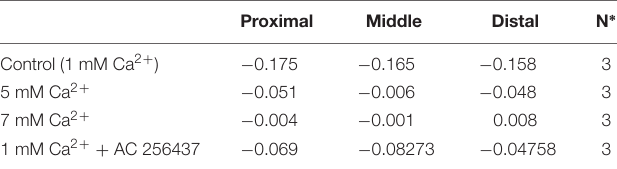
TABLE 3 | (cid:49) Fluorescence/Minute Mean in the presence of intraluminal FSK. Proximal Middle Distal N ∗